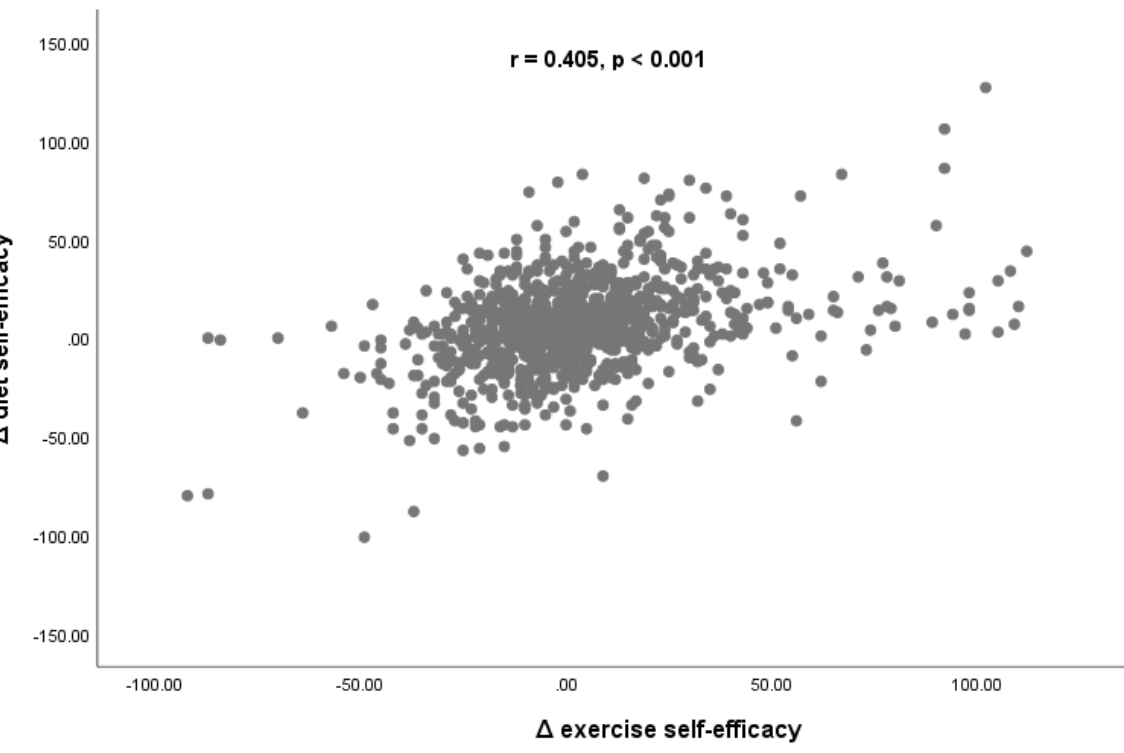
Figure 2. Scatterplot of ( ∆ ) differences (post- vs. pre-intervention) between diet and exercise self- efficacy and their correlation.